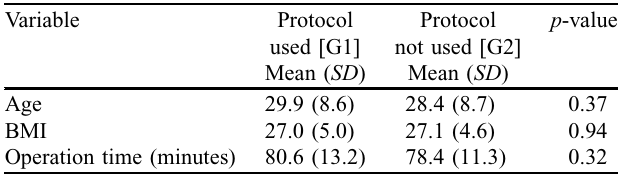
Table 1. Comparison between mean age, body mass index and operation time among both